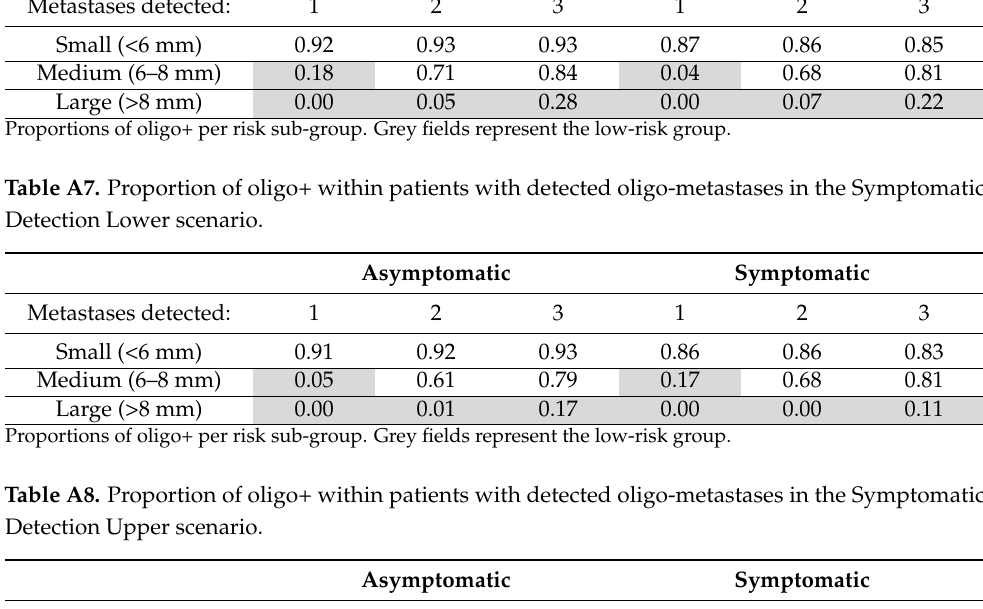
Proportions of oligo+ per risk sub-group. Grey fields represent the low-risk group. Table A6. Proportion of oligo+ within patients with detected oligo-metastases in the R Upper scenario.